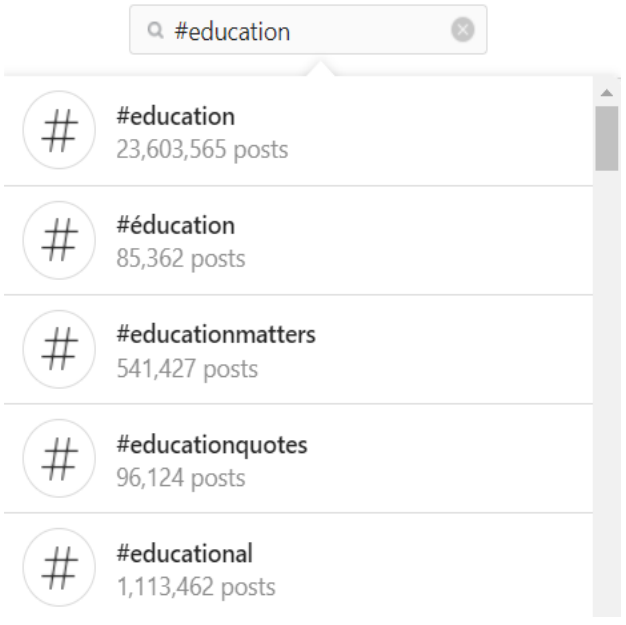
Figure 1. Selected